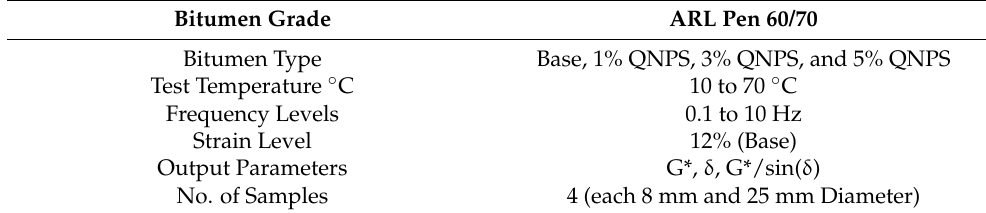
Table 6. Test Table 6. Test matrix.